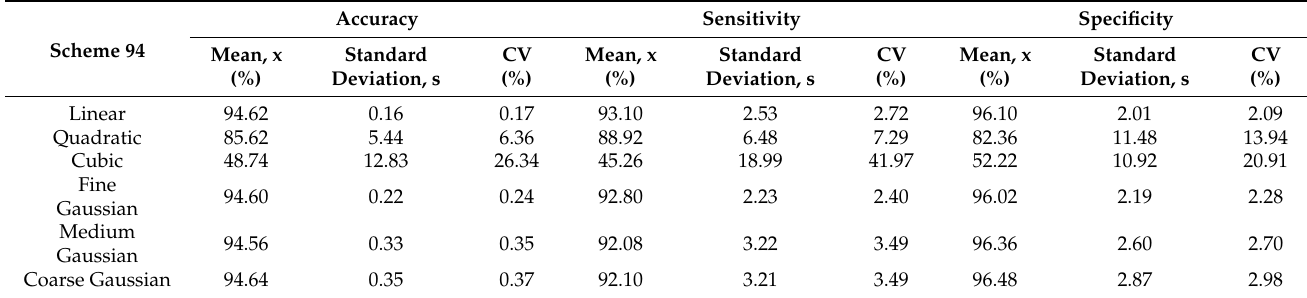
Table 7. Mean (x) and standard deviation (s) and coefficients of variations (CV) for accuracy, sensitivity, and specificity of each SVM